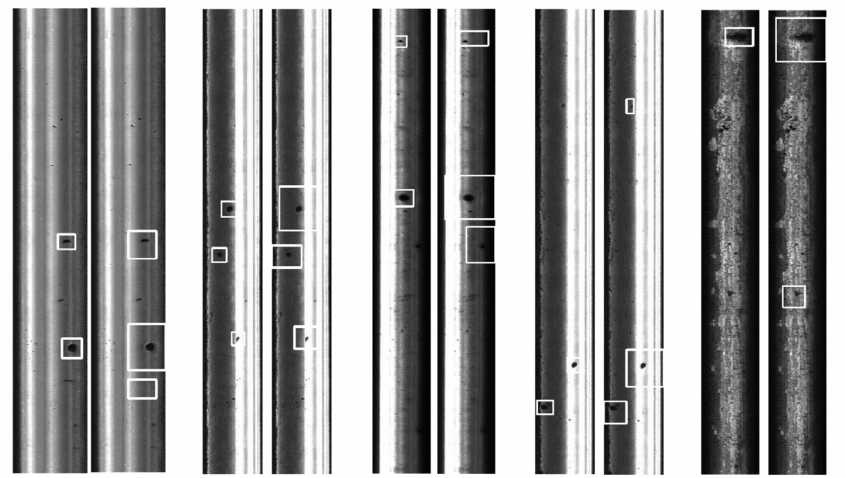
Figure 10. The histograms ( top row) and PDFs ( bottom row) for Non-Defect class ( left column) and Defect class ( right column) of Type-I RSDDs data set [25].